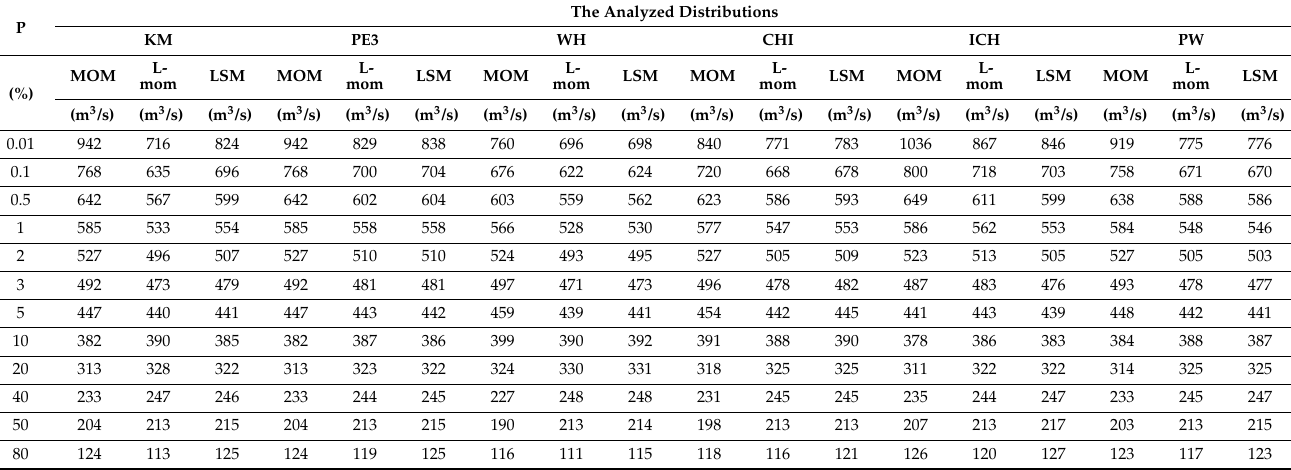
Table 7. Quantile results of the analyzed